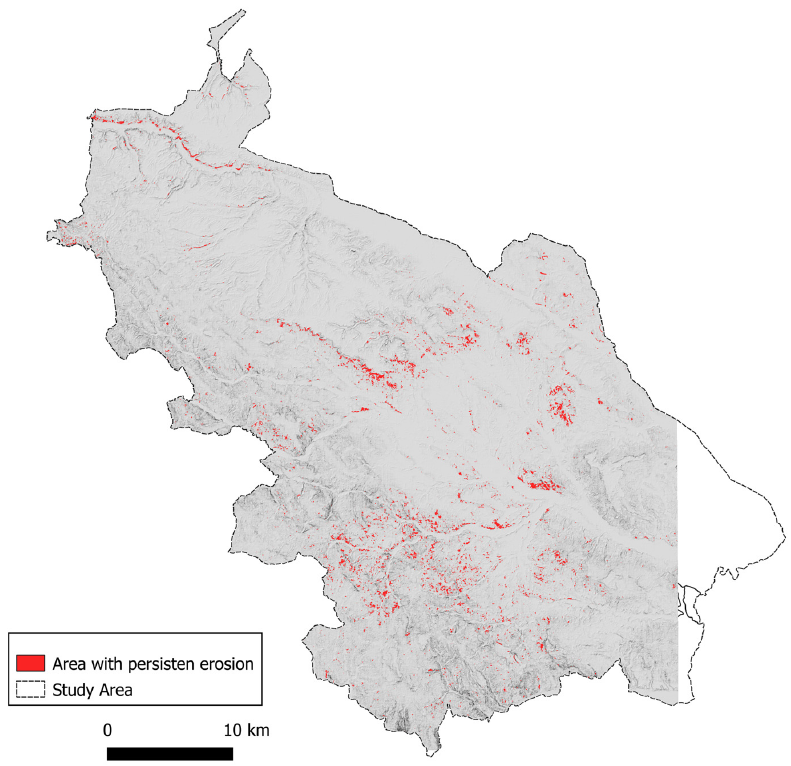
Figure 6. Map of permanent erosion between October 2019 and September 2020.